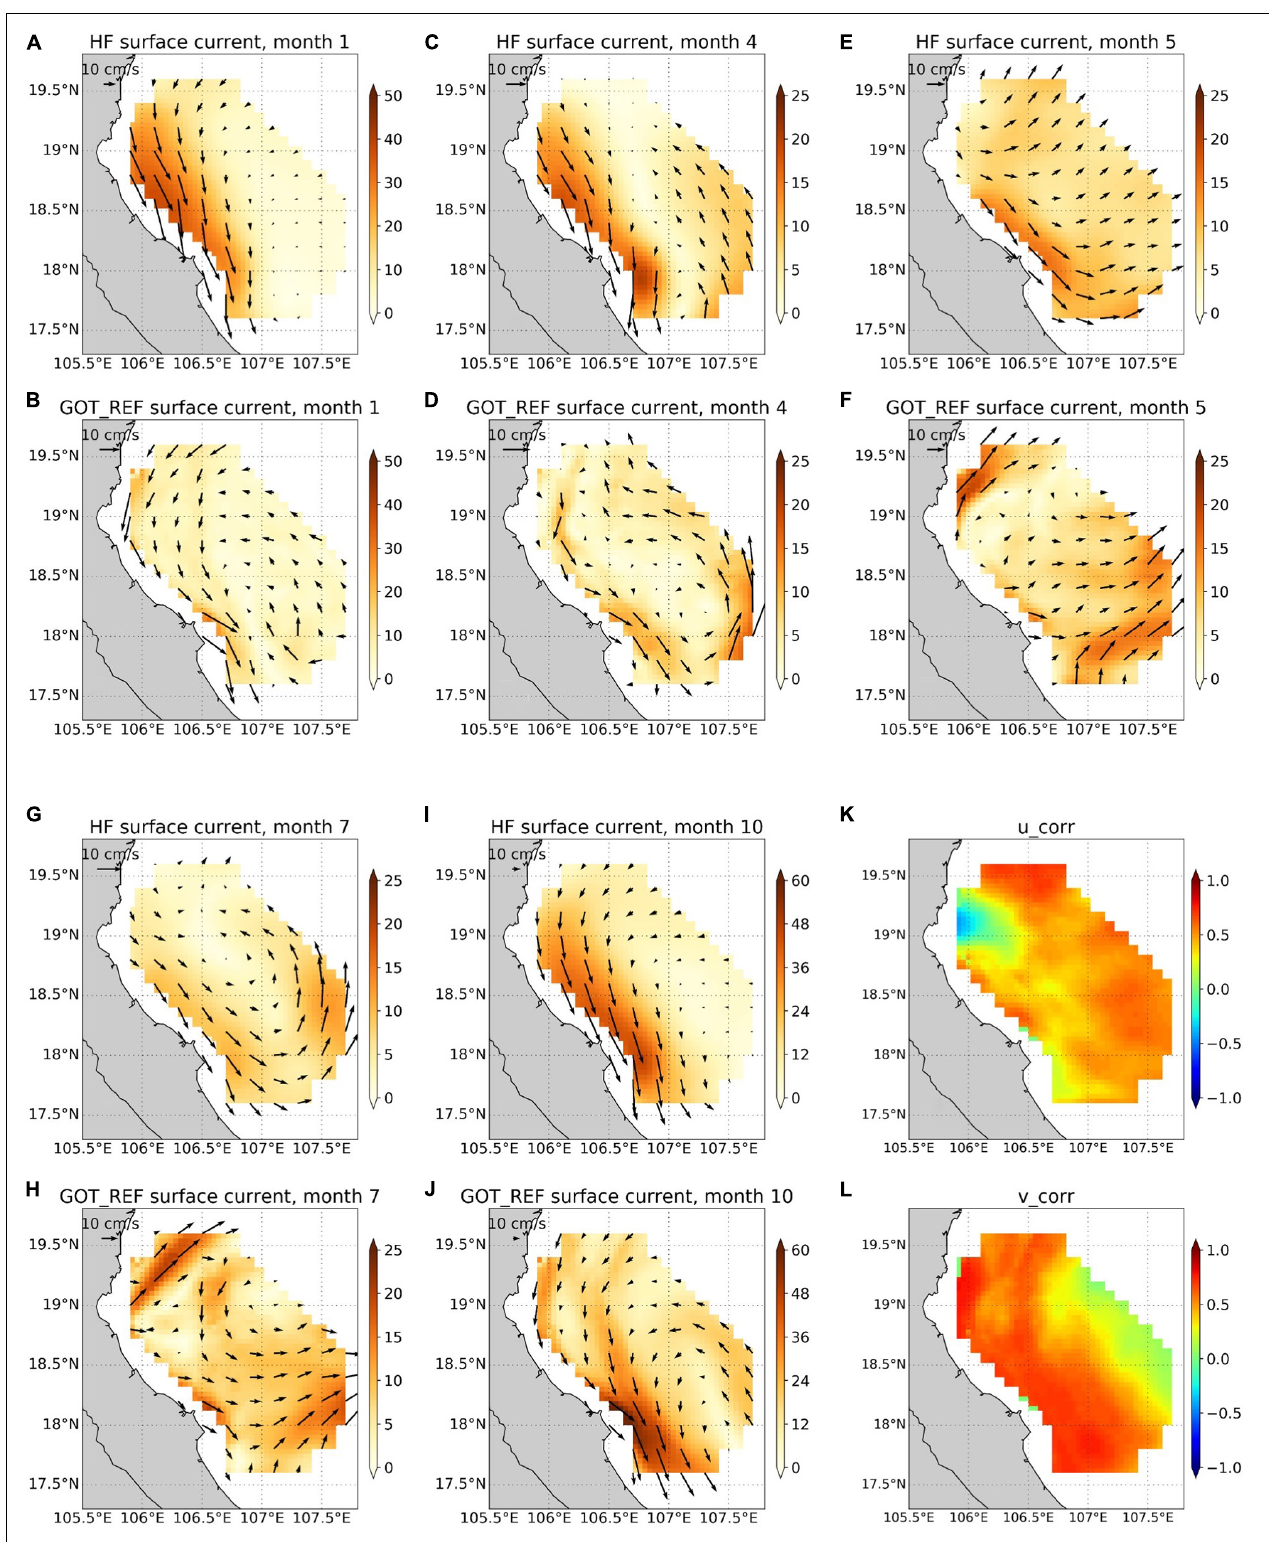
FIGURE 6 | Surface current from HFR data (A,C,E,G,I) and model simulations (B,D,F,H,J) for different months of 2015 (Jan, Apr, May, Jul, Oct) (cm/s). Temporal correlation of u and v (K,L) computed from daily currents. Note: Different color bar scales.